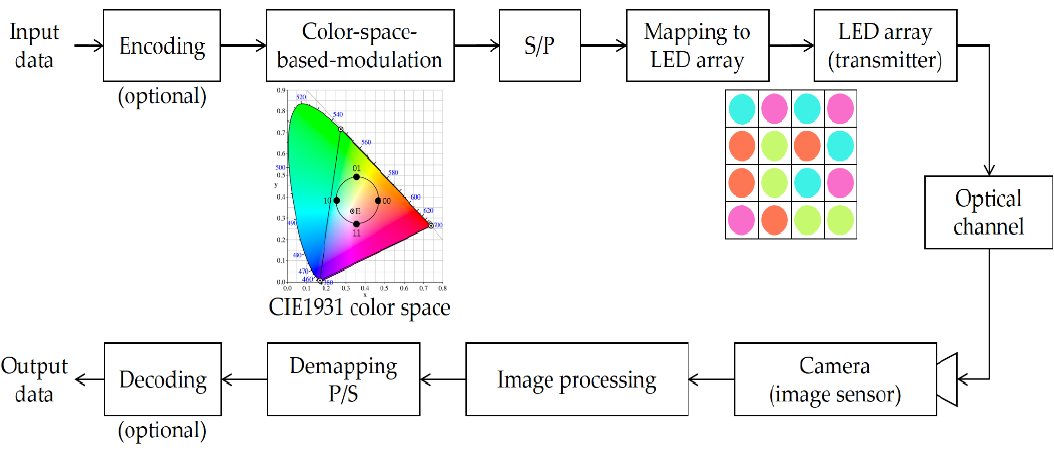
Figure 2. Generation example of a constellation diagram for a target color in CIELUV color space Figure 3. Color-space-based, color-independent visual-MIMO tranceiving procedure using image processing. (example uses seven LEDs and two bit data symbols).